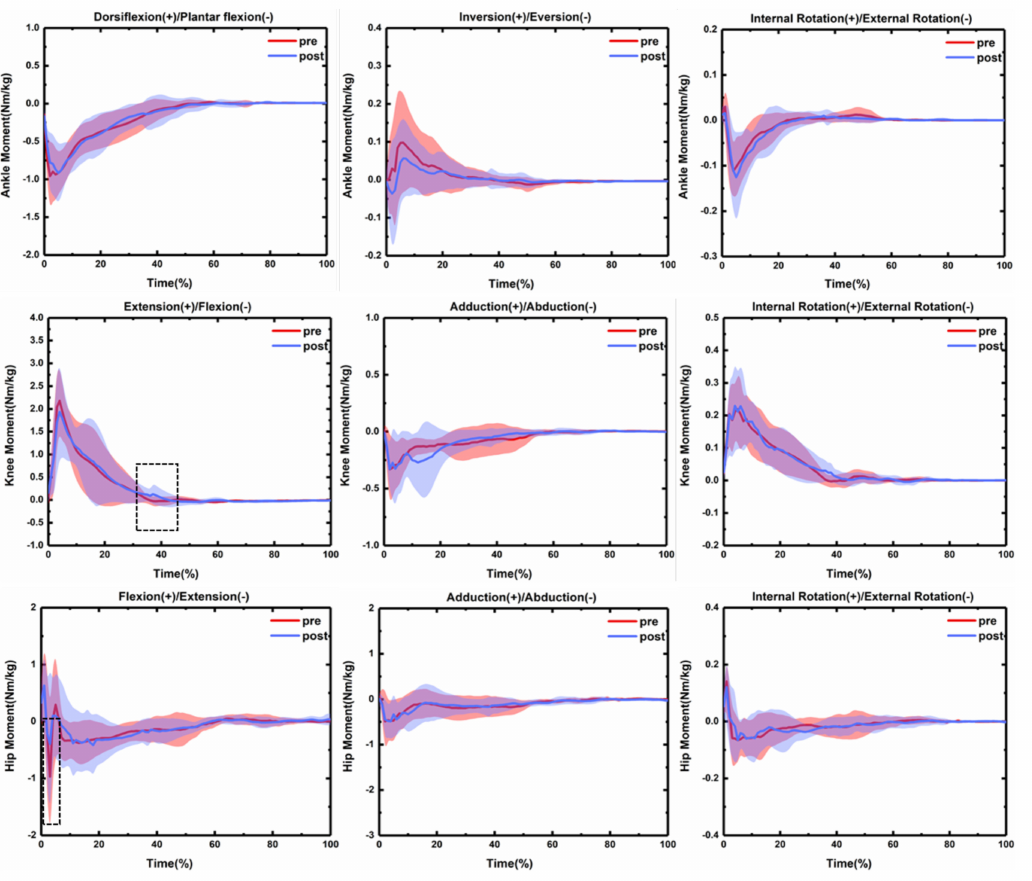
Figure 5. The joint moments between pre- (red solid lines) and post-fatigue (blue solid lines) during the landing phase. Shaded areas mean standard deviation. Black dotted boxes indicate significant di ff erences between the two conditions.